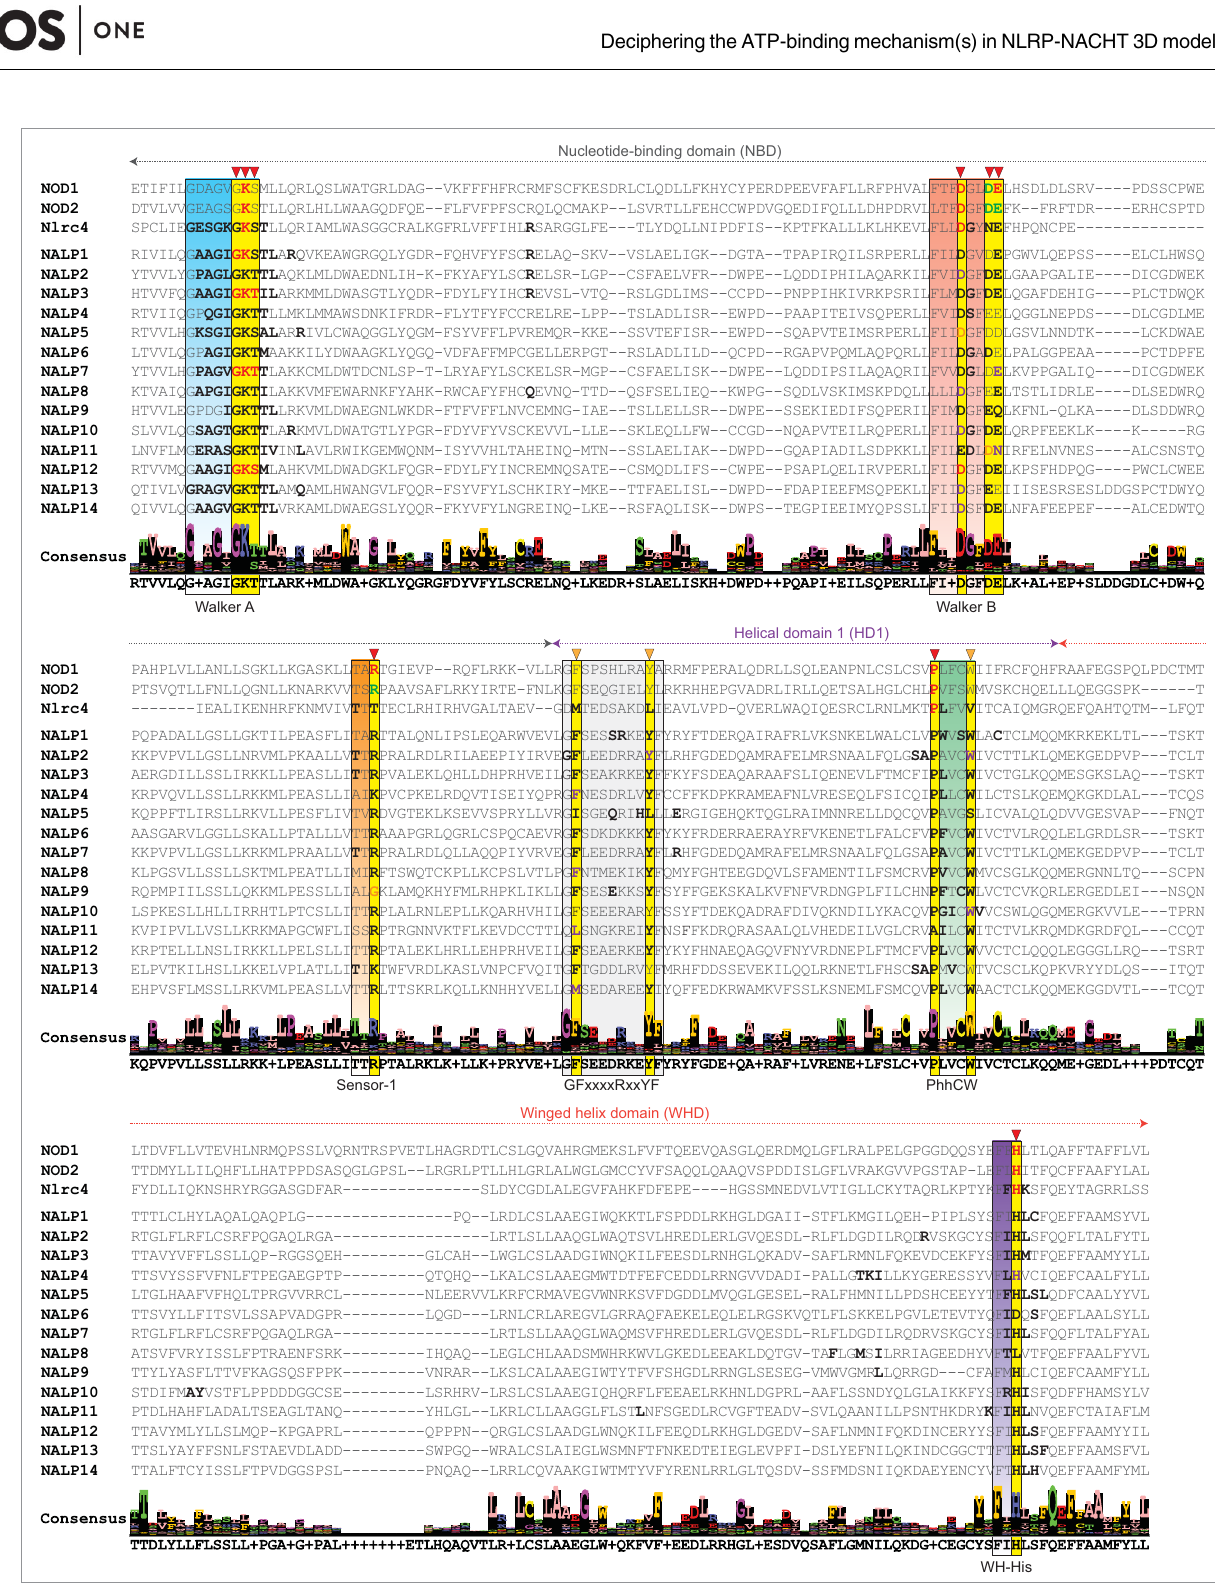
Fig 4. Multiple sequence alignment of NACHT domains of NLRPs, NOD1, NOD2 and Nlrc4; the residues interacting with ATP are displayed in bold fonts. The critical ATP-binding residues (proved experimentally), presented in red-bold font; the residues found within 5-6 Å of ATP (adopted from atomic/residual distance calculation; Fig 4) are visualized in black fonts. The sequence motifs crucial for ATP binding are boxed in different colors (Walker A: blue; Walker B: salmon; Sensor 1: orange; GFxxxxRxxYF motif: light gray; PhhCW motif: green; WH-His: purple). The key ATP- coordinating residues are highlighted in yellow boxes and are marked in inverted